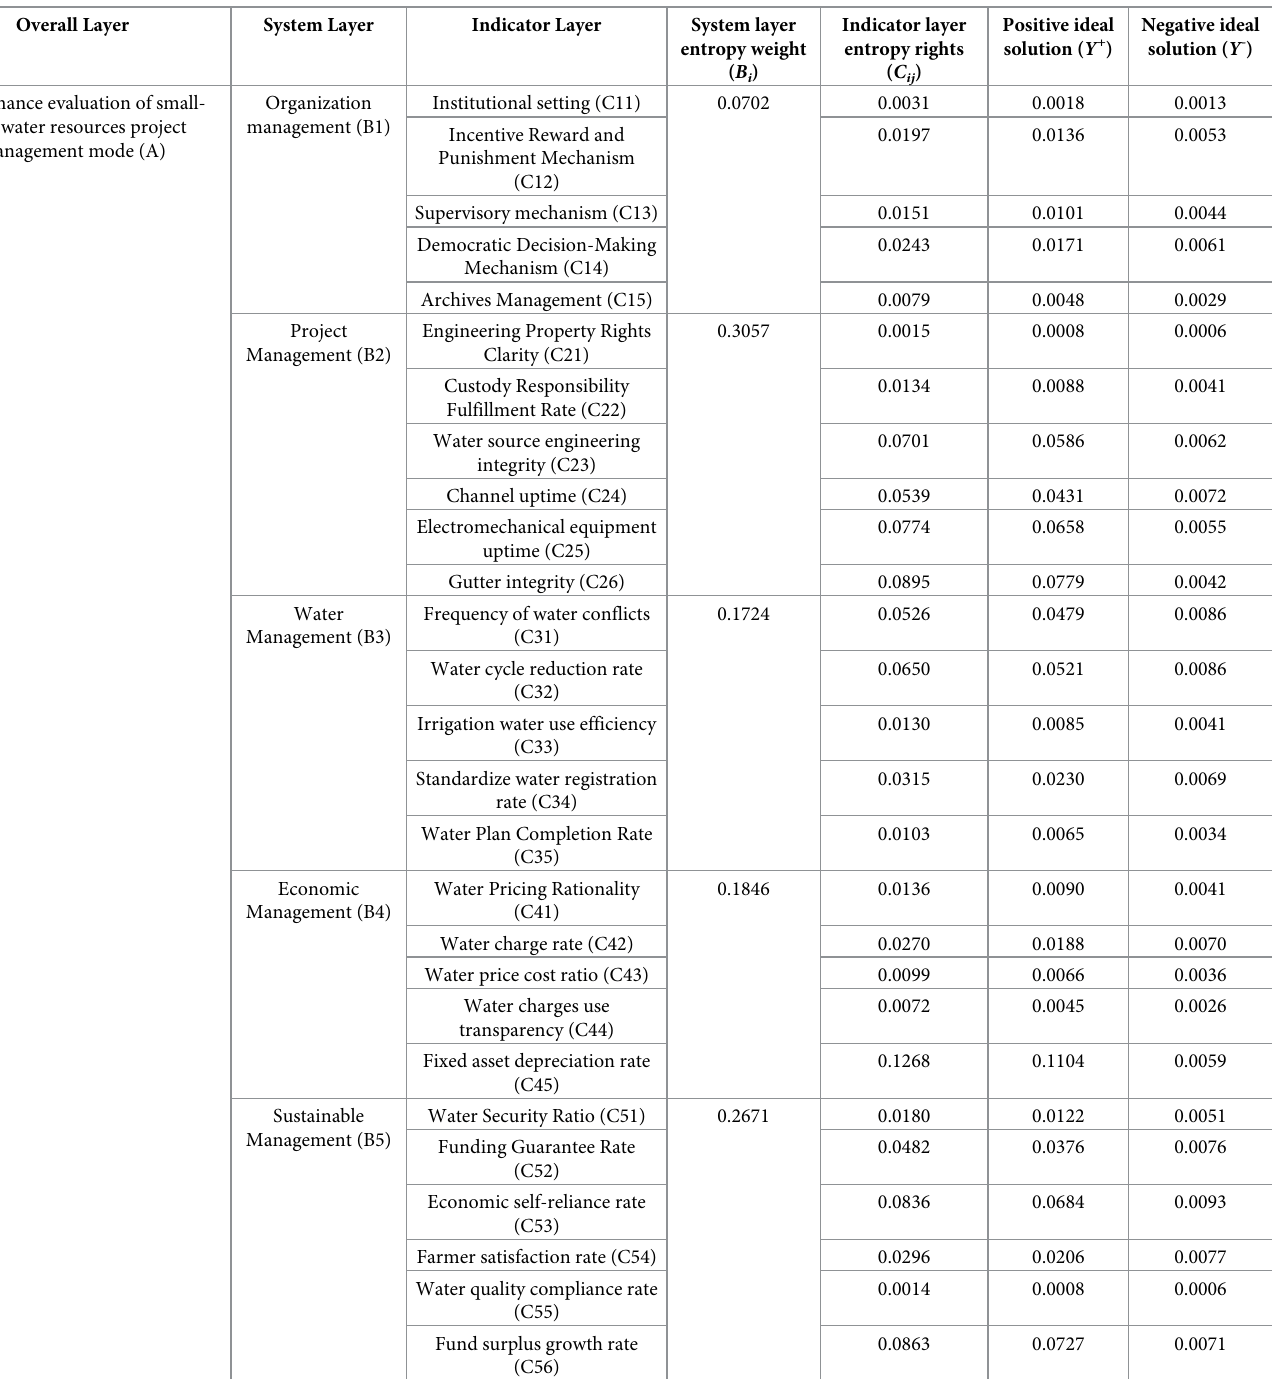
Table 5. Weights of each indicator and positive and negative ideal